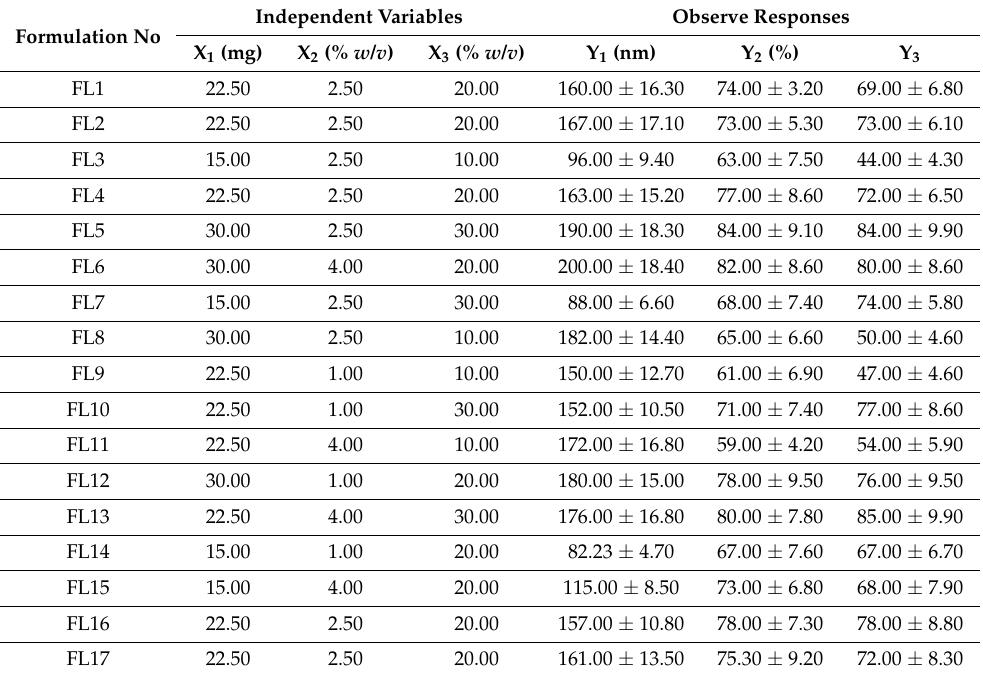
Table 2. Formulations with composition of individual independent variables and observe responses of PLM-loaded glycerosome in Box–Behnken